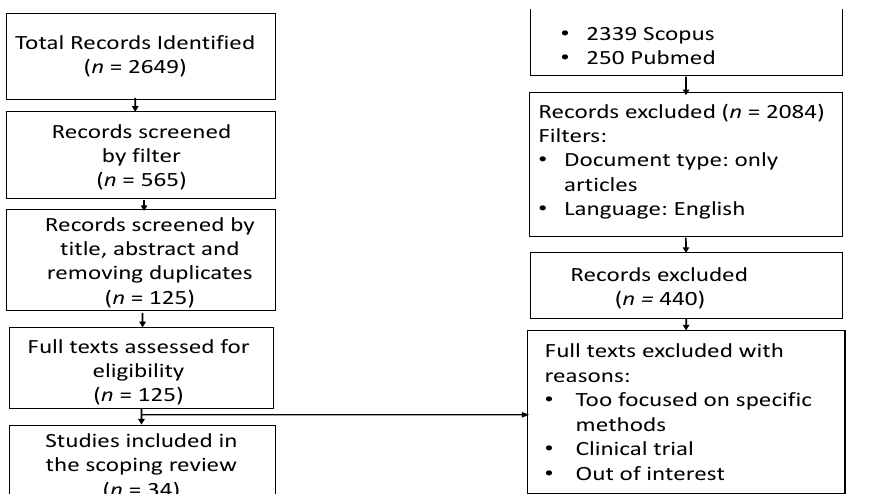
Figure 4. Criteria for the inclusion of articles.